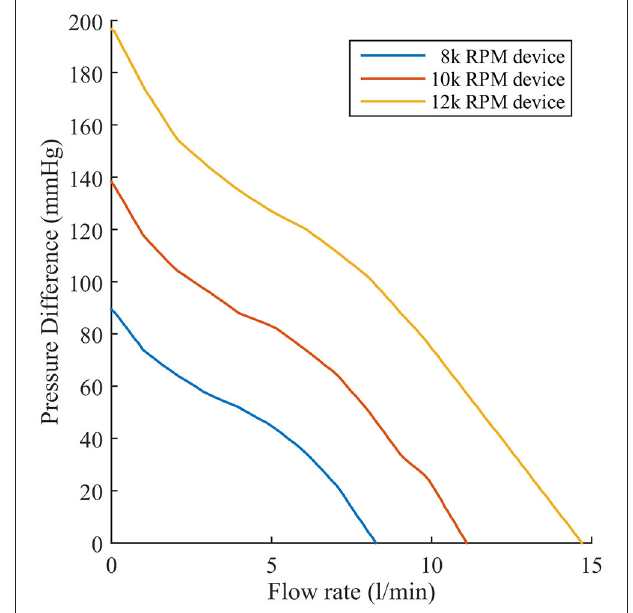
FIGURE 3 | Experimentally recorded flow rates of the Heartmate II TM LVAD operating at 8, 10, and 12k RPM as a function of pressure